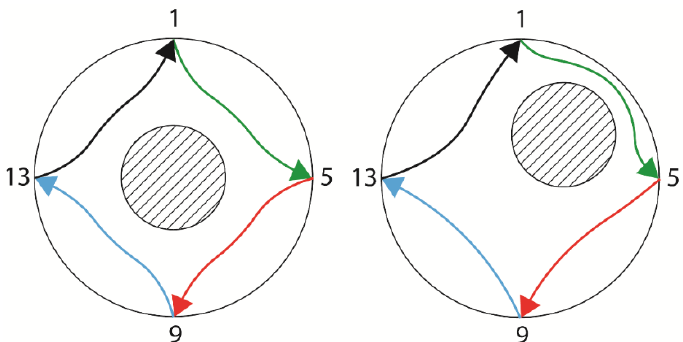
Figure 4. Electric field lines of the 90° measurements when the core is centered ( left ) and when the core is out of center ( right ). Each color represents one measurement.